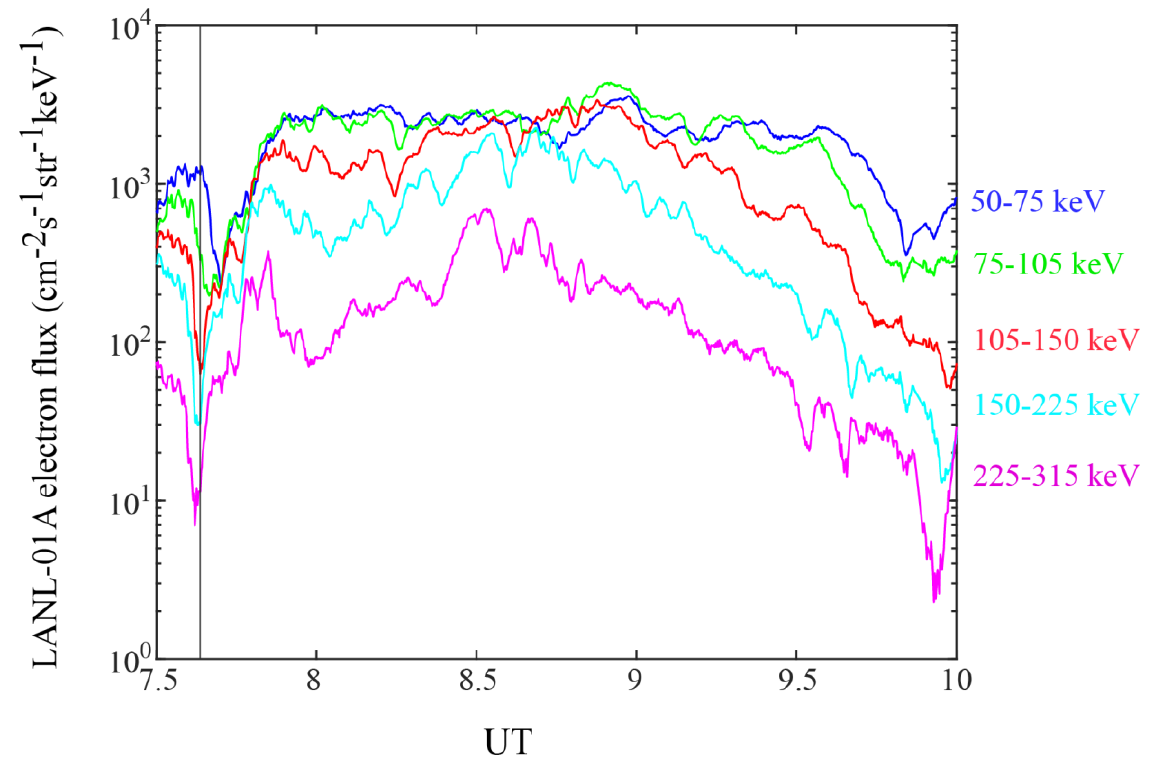
Figure 3. The electron fluxes observed by LANL-01A satellite in five different energy channels from 07:30 UT to 08:00 UT on 8 November 2004. The LANL-01A injected time is showed by vertical line, while the MLT of LANL-01A is 8.4.